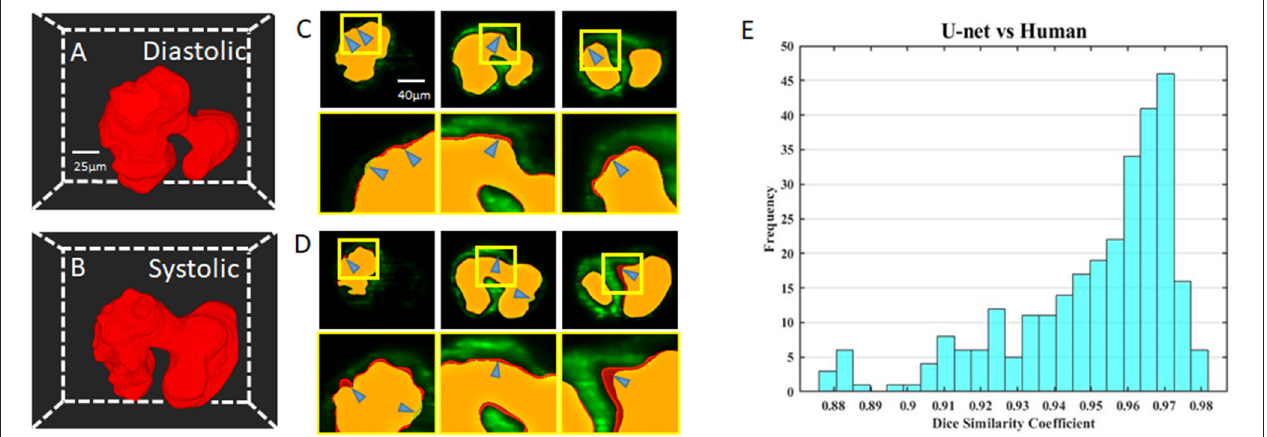
FIGURE 3 | Comparison of U-net based autosegmentation to manual hand segmentation. (A,B) Geometric representation of both the diastolic and systolic stages of the heart cycle. (C,D) Comparison in the 2D axial plane between autosegmentation of the U-net and ground truth in both the diastolic and systolic stages, respectively. The blue arrows indicate areas of disjoint space within the segmentations, shown in red (manual segmentation), green (autosegmentation), and yellow (intersection). (E) Corresponding Dice similarity coefficient comparing the results between our ground truth and automatic segmentation demonstrated the ability of autosegmentation.